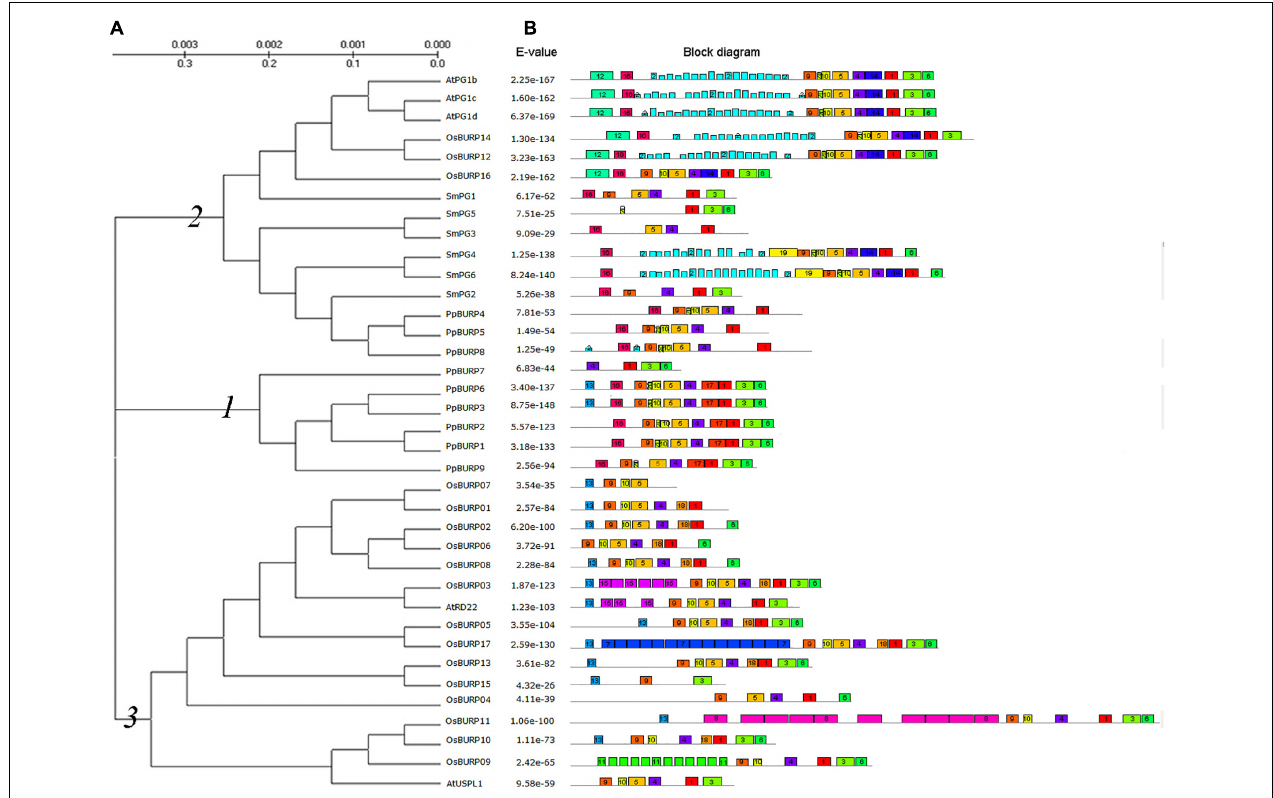
FIGURE 1 | Phylogenetic relationship and motif structures of BURP domain-containing proteins from diverse species. (A) The unrooted tree was generated using the Molecular Evolutional Genetics Analysis version 5 (MEGA5) program by the Maximum-likelihood method. The bootstrap values were indicated at the lines. The abbreviations of species names are as follows: At, Arabidopsis thaliana ; Os, Oryza sativa ; Pp, Physcomitrella patens ; Sm, Selaginella moellendorffii . (B) Multiple expectation maximizations for motif elicitation (MEME) motif search results. Conserved motifs are indicated in numbered, colored boxes. E -value is shown on the left. The accession number is shown in Supplementary Table 2